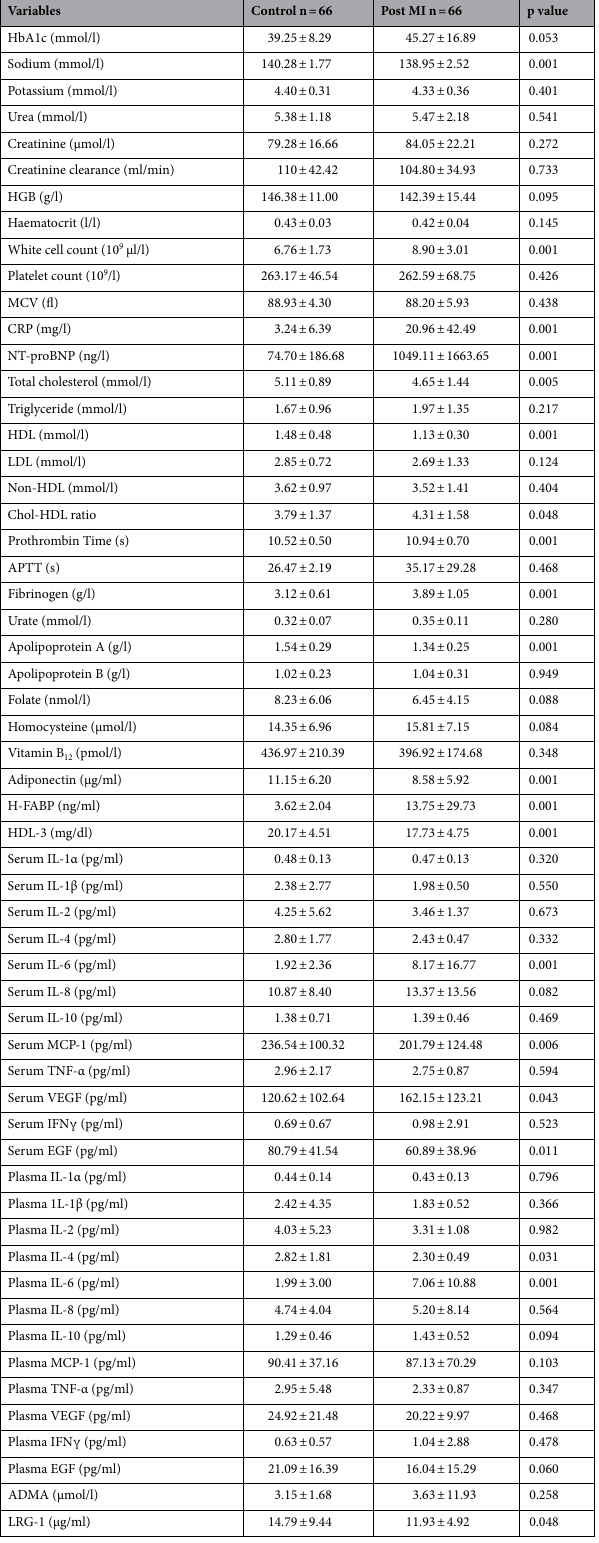
Table 3. Biomarker results (mean ± SD). HbA1c glycated haemoglobin, HGB haemoglobin, MCV corpuscular volume, HDL high-density lipoprotein, LDL low-density lipoprotein, Chol-HDL